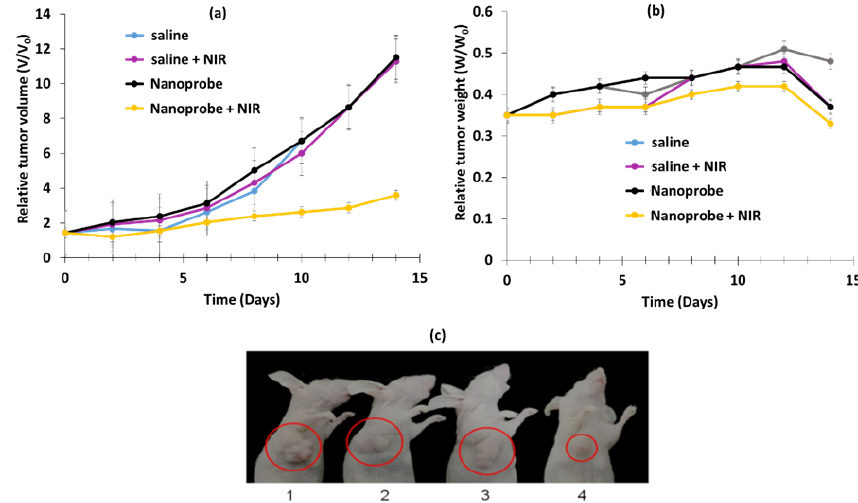
Figure 18. Four groups of HeLa tumor-bearing BALB/c nude mice. ( a , b ) Relative tumor volume, ( c ) relative tumor weight when treated with (1) saline, (2) saline + NIR, (3) nanoprobe, (4) nanoprobe + NIR. NIR laser irradiation (808 nm, 1.0 W/cm 2 , 40 min). The nanoprobe was MUCNPs/800WC/RB/Cy3/pep-QSY7. [Nanoprobe] = 300 µg/mL. Figures ( a , b ) adapted from Li et al. [40] . Figure ( c ) reprinted with permission from Li et al. [40] . Copyright 2020 American Chemical Society.